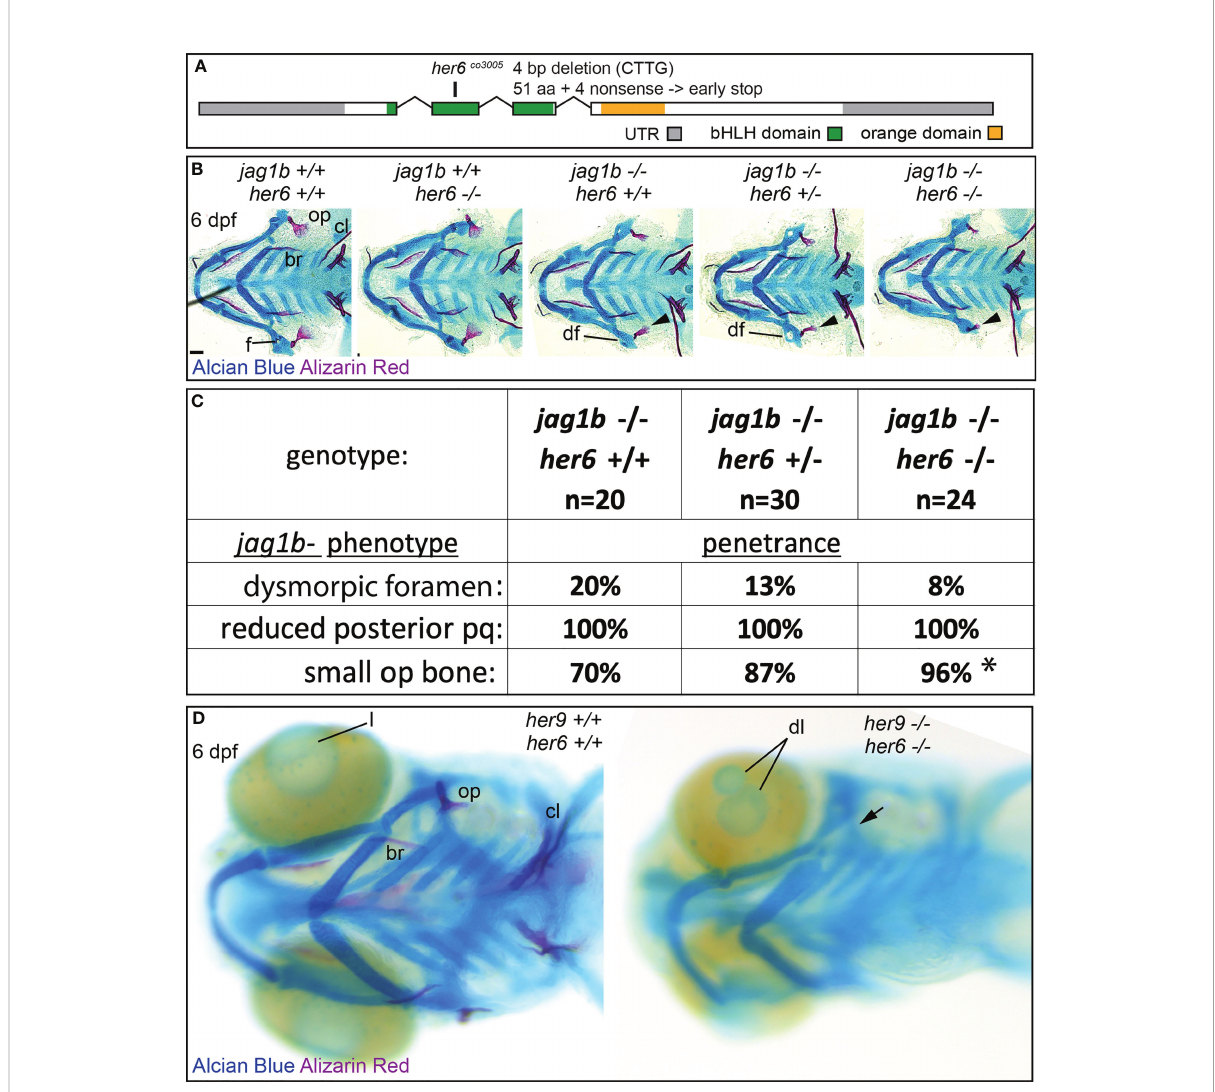
FIGURE 8 Mutations in her6 enhance the jag1b mutant phenotype, her6 and her9 are redundantly required for eye development. (A) Exon diagram for her6 indicating the untranslated regions (UTR) and the regions predicted to encode the basic helix-loop-helix (bHLH) and Orange domains. The location of the deletion encoded by the her6 co3005 allele is indicated. (B) jag1b ; her6 double heterozygotes were intercrossed and six days post fertilization (dpf) larvae were stained with Alcian Blue and Alizarin Red to label cartilage and bone. The individuals were then genotyped, the viscerocrania were dissected and fl at mounted then imaged. The following craniofacial skeletal elements are indicated in the wild-type individual: opercle bone (op), branchiostegal ray (br), cleithrum (cl), foramen (f). The dysmorphic foramen phenotype (df) is indicated, and the small op bone phenotype is indicated by an arrowhead. Scale bar is 50 m m (C) Genotyped preps from B were scored for penetrance of jag1b mutant-associated phenotypes. Asterisk in small op bone row indicates that penetrance in jag1b -/-; her6 -/- is signi fi cantly different from jag1b -/-; her6 +/+ (p<0.05). (D) her6 ; her9 double heterozygotes were intercrossed and six days post fertilization (dpf) larvae were stained with Alcian Blue and Alizarin Red to label cartilage and bone. The individuals were then genotyped and whole-mount imaged. An arrow indicates unmineralized opercle. The lens (l) is indicated in the wild type and a double lens phenotype is indicated in double homozygous mutants